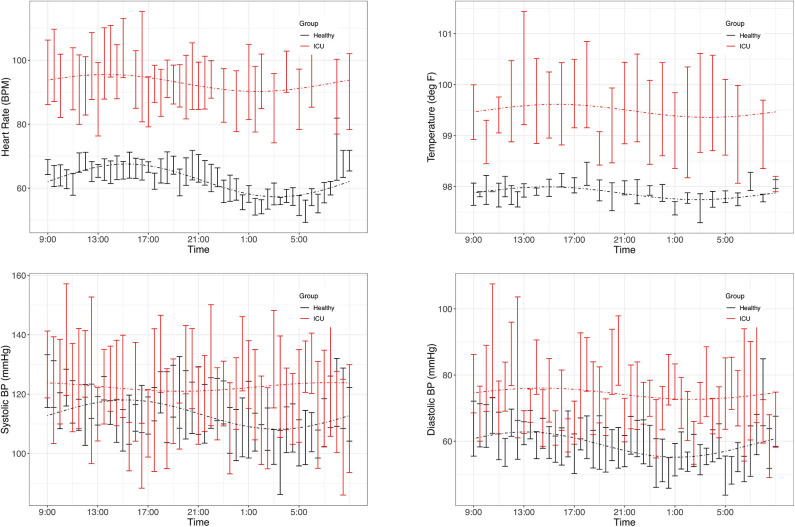
Time series plots of vitals. Data are presented as mean and standard error in ICU patients (red) and healthy controls (black). Clockwise: heart rate, temperature, diastolic blood pressure, systolic blood pressure. Dashed lines represent the PMC fits of the 24-h rhythm to the data. Plots of the individual data are presented in Supplementary Data Sheet 1.